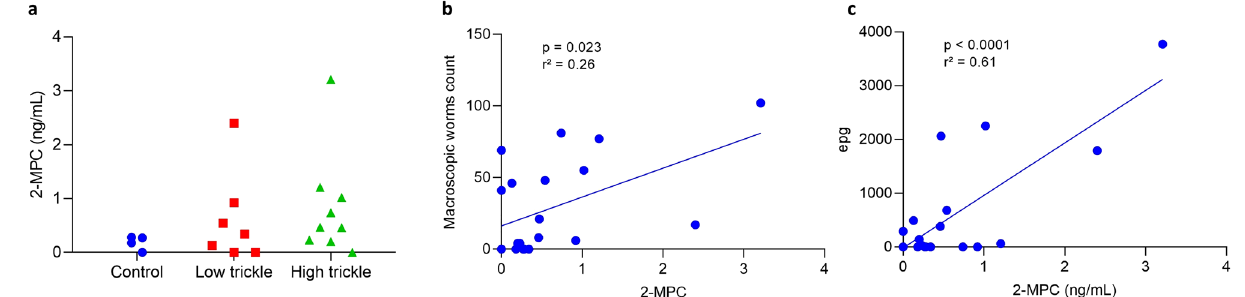
Figure 6. Quantification of urinary 2-MPC in A. suum infected pigs: control group, low and high trickle infected pigs ( a ) and correlation between urinary 2-MPC and macroscopic worms count ( b ) and epg count ( c